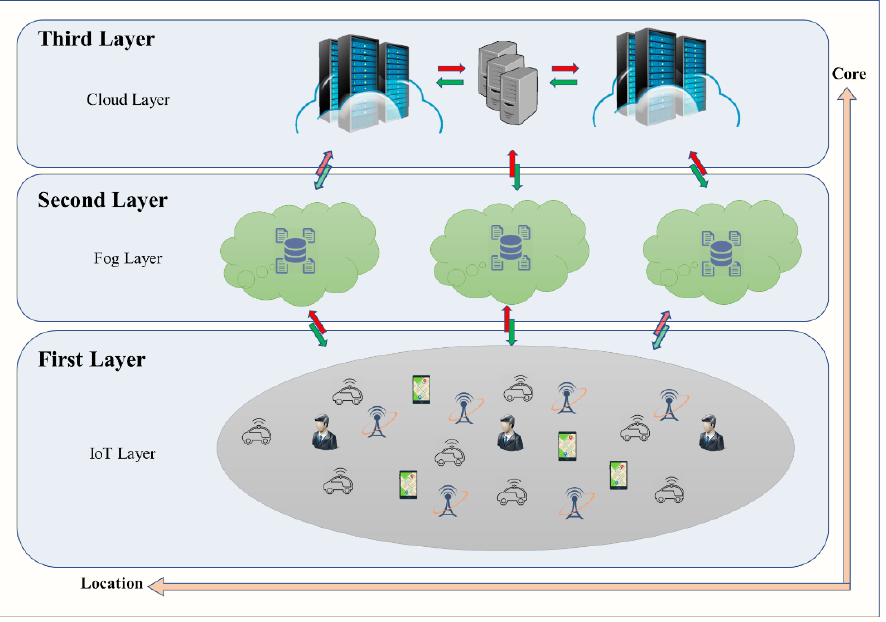
Figure 1. A basic conceptual framework of IoT, cloud computing, and fog computing.